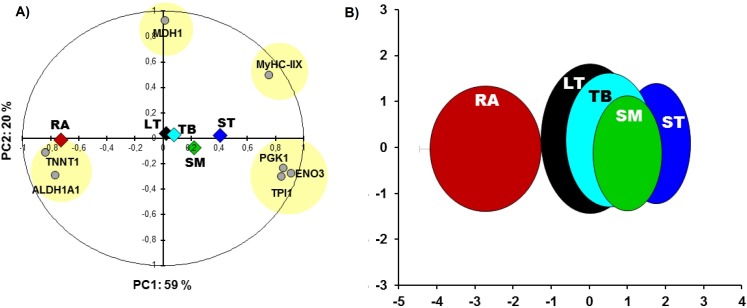
Principal component analysis (PCA).(A) Comparisons between the five muscles according to proteins of metabolic (MDH1, ALDH1A1, PGK1, ENO3, TPI1) and contractile properties (MyHC-IIX and TNNT1). The projections of the mean individuals for each muscle are shown in the same PCA by their barycenter’s and corresponding color on both axes. (B) the bi-plot of the projection of the individuals of the five muscles: RA (red), LT (black), TB (cyan), SM (green) and ST (blue) that are encircled in ellipses (x,y-means ± x,y-standard deviation (SD) as in Gagaoua, Picard & Monteils (2018c)) using the corresponding schematic colors. The overall Kaiser-Mayer-Olkin score of the PCA was 0.73 (Bartlett’s test of sphericity was significant, P < 0.001). The eigenvalues of PC1 and PC2 are 4.2 and 1.4, respectively.